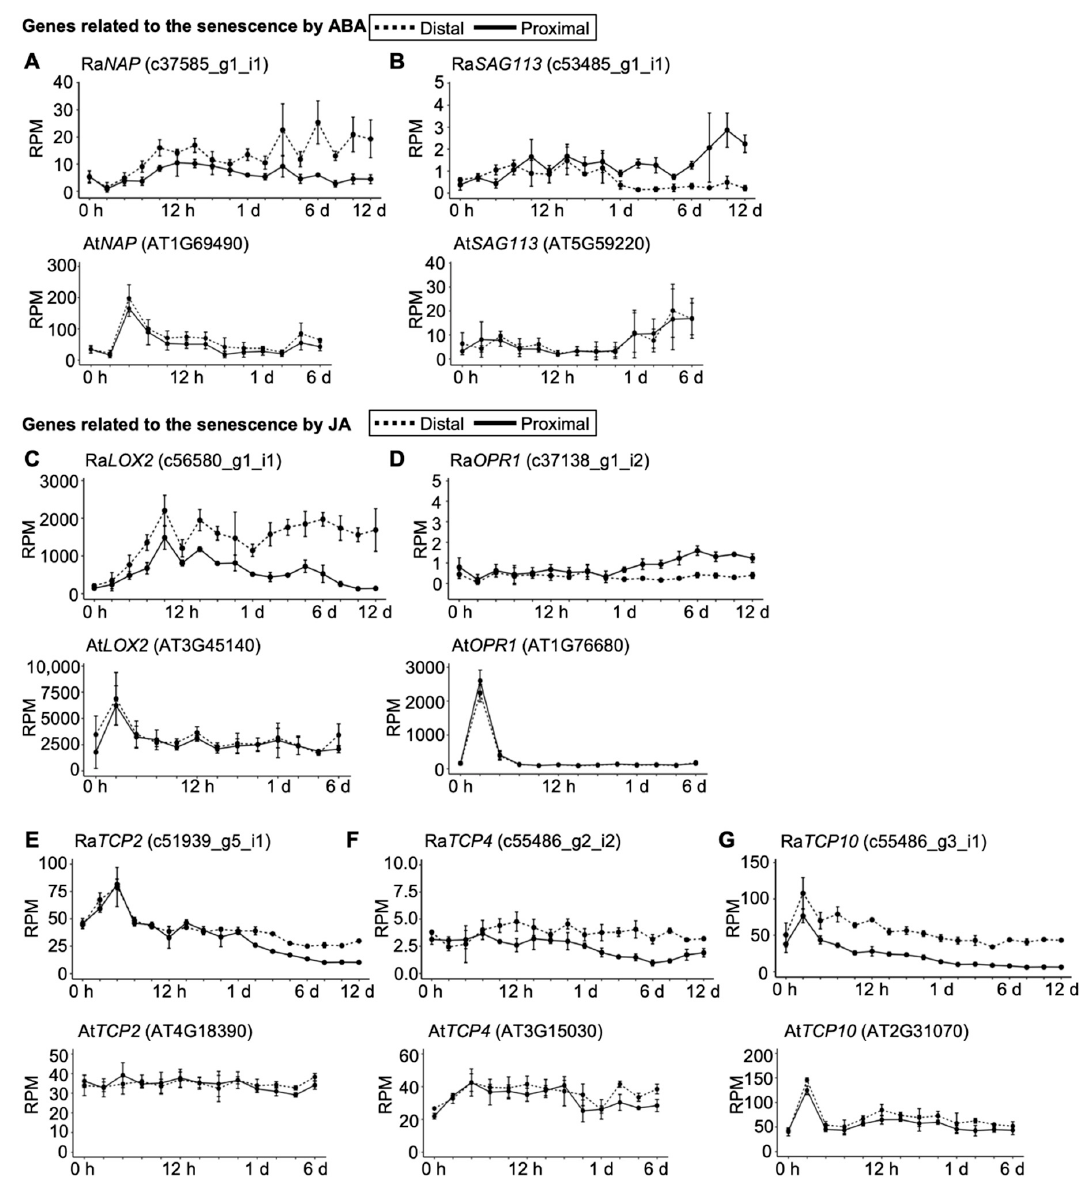
Figure 4. Expression profiles of senescence-related genes and orthologs. ( A , B ) Expression profiles of senescence-related genes and orthologs affected by abscisic acid (ABA). ( C – G ) Expression profiles of senescence-related genes and orthologs a ff ected by jasmonic acid (JA). Upper and lower panels depict expression profiles of R. aquatica and A. thaliana , respectively. Dotted and solid lines indicate expression levels at the distal and proximal sides, respectively. Vertical line and horizonal lines indicate reads per million (RPM) and time points, respectively. Data are presented as mean ± SE ( n =